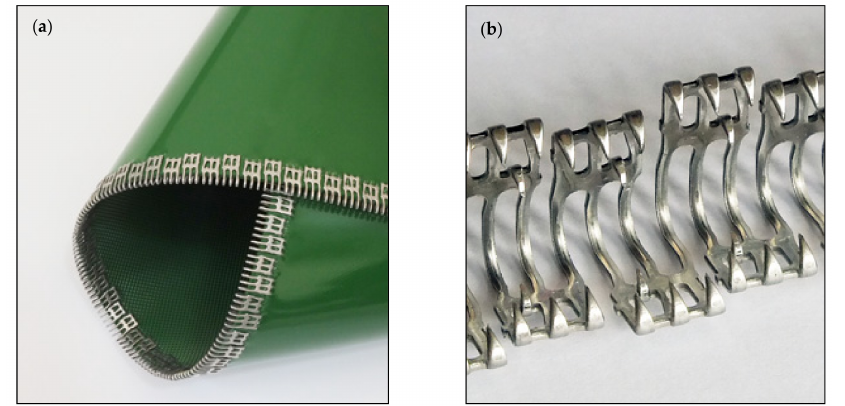
Figure 19. Metal teeth fastening: ( a ) general view; ( b ) single string of mechanical fasteners [26]. Another design solution is the example shown in Figure 20. Clamping system that only requires a hard surface and a hammer. The upper part of the fastener has special hooks which, during assembly, stop on the lower part of the coupler, catching on convex bridges.